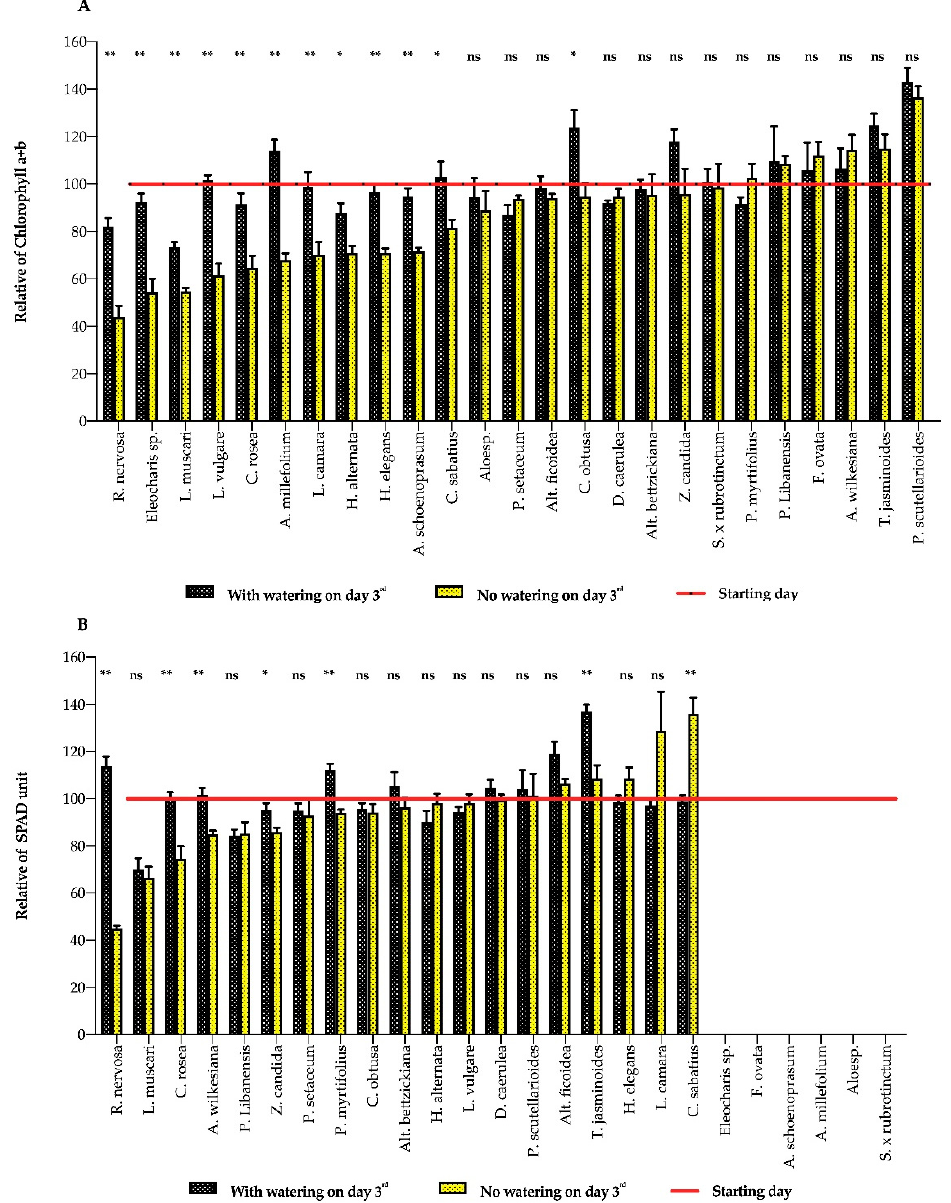
Figure 4. Effect of water deficiency on relative total clorophyll content ( A ) and SPAD units ( B ) on the 3rd day of the experiment for different plant species. Bars and error bars represeant mean ± SE. Non significant (ns) and significant differences (* at p < 0.05 and ** at p < 0.01 by Student’s T-test between no watering at 3 days are shown above the bars.